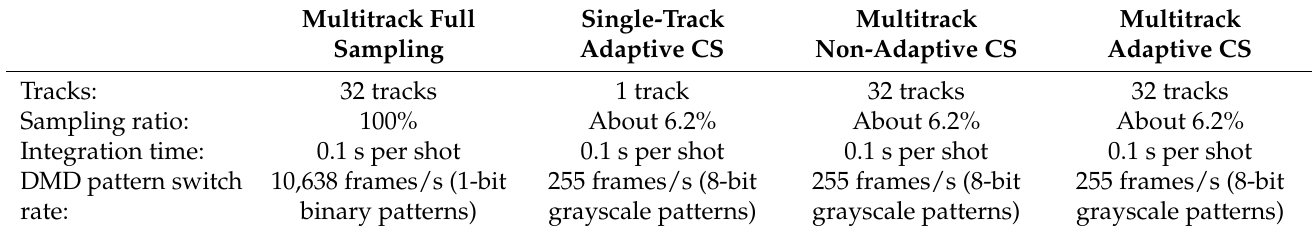
Table 1. A summary of methods and a comparison of their key features. Multitrack